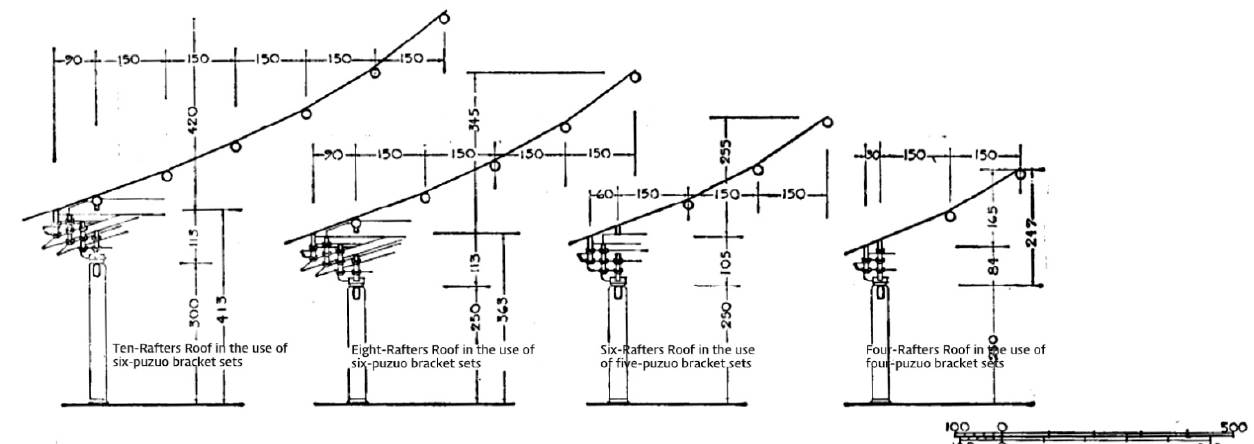
Figure 4. A proportional concept on the roof purlins location according to the eave columns’ height, Adapted from Chen (1981, p. 4).